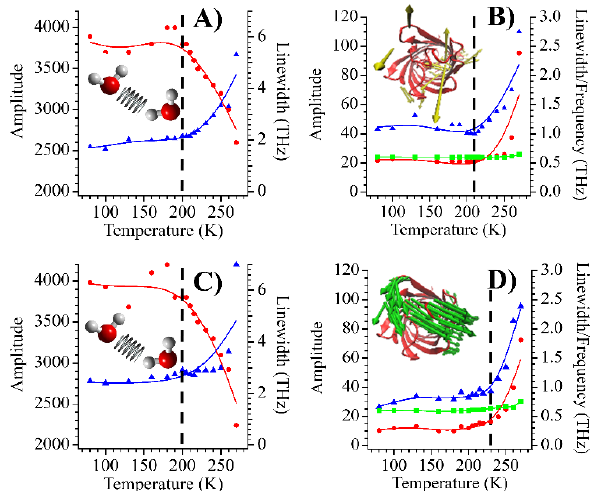
Figure 6. Resonance fitting parameters for photoactive (top) and photobleached (bottom) TagRFP-T. ( A , C ) Amplitude (circle, red) and linewidth (triangle, blue) corresponding to water intermolecular resonance centered at 5.3 THz. ( B , D ) Amplitude (circle, red), linewidth (triangle, blue), and central frequency (square, green) of the protein intramolecular resonant band; the photobleached state shows higher collectivity of the motion. The interpolated lines are used as a guide for the eye.